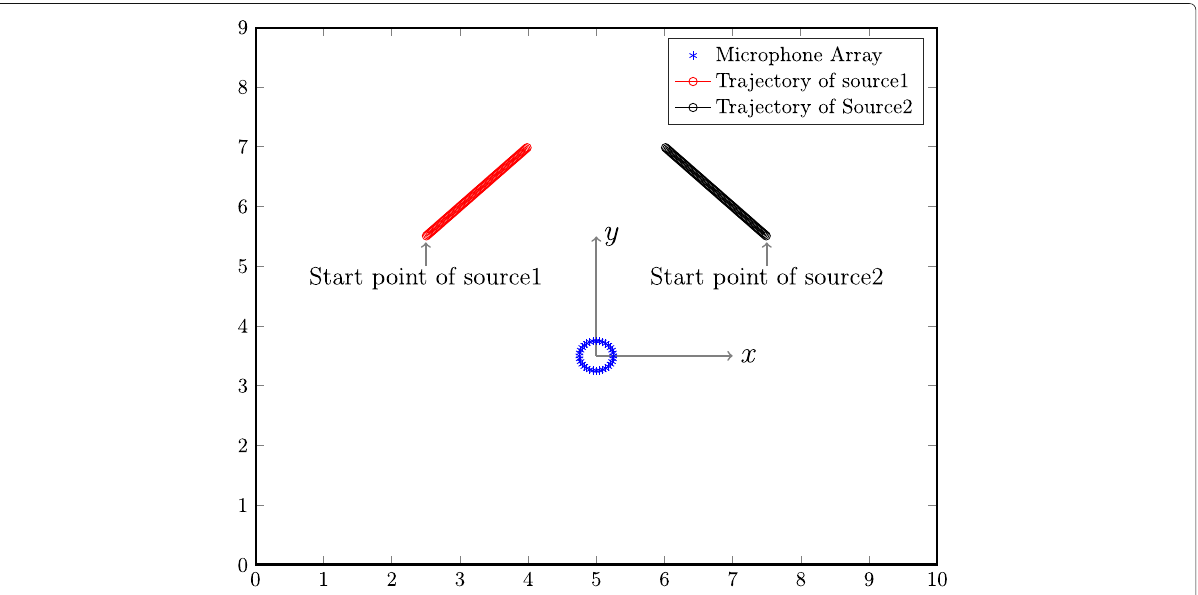
Fig. 8 Illustration of the second virtual room setup with two moving sources for the simulation 2